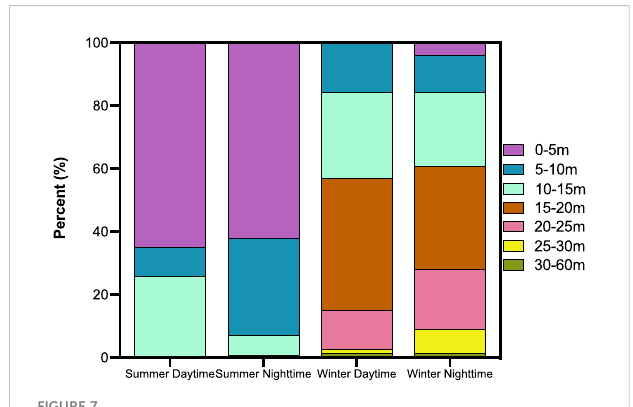
FIGURE 7 Fish density ratio of each water layer from four hydroacoustic surveys in Yudong